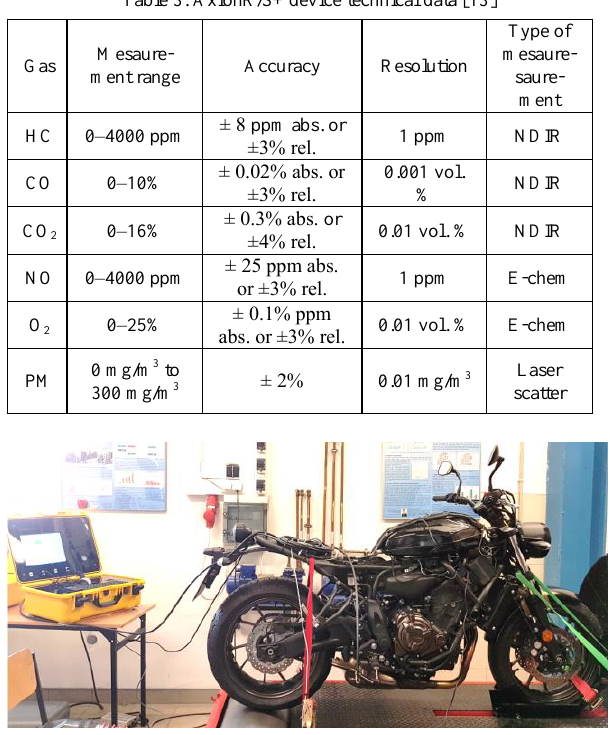
Fig. 6. WMTC test cycle speed curve